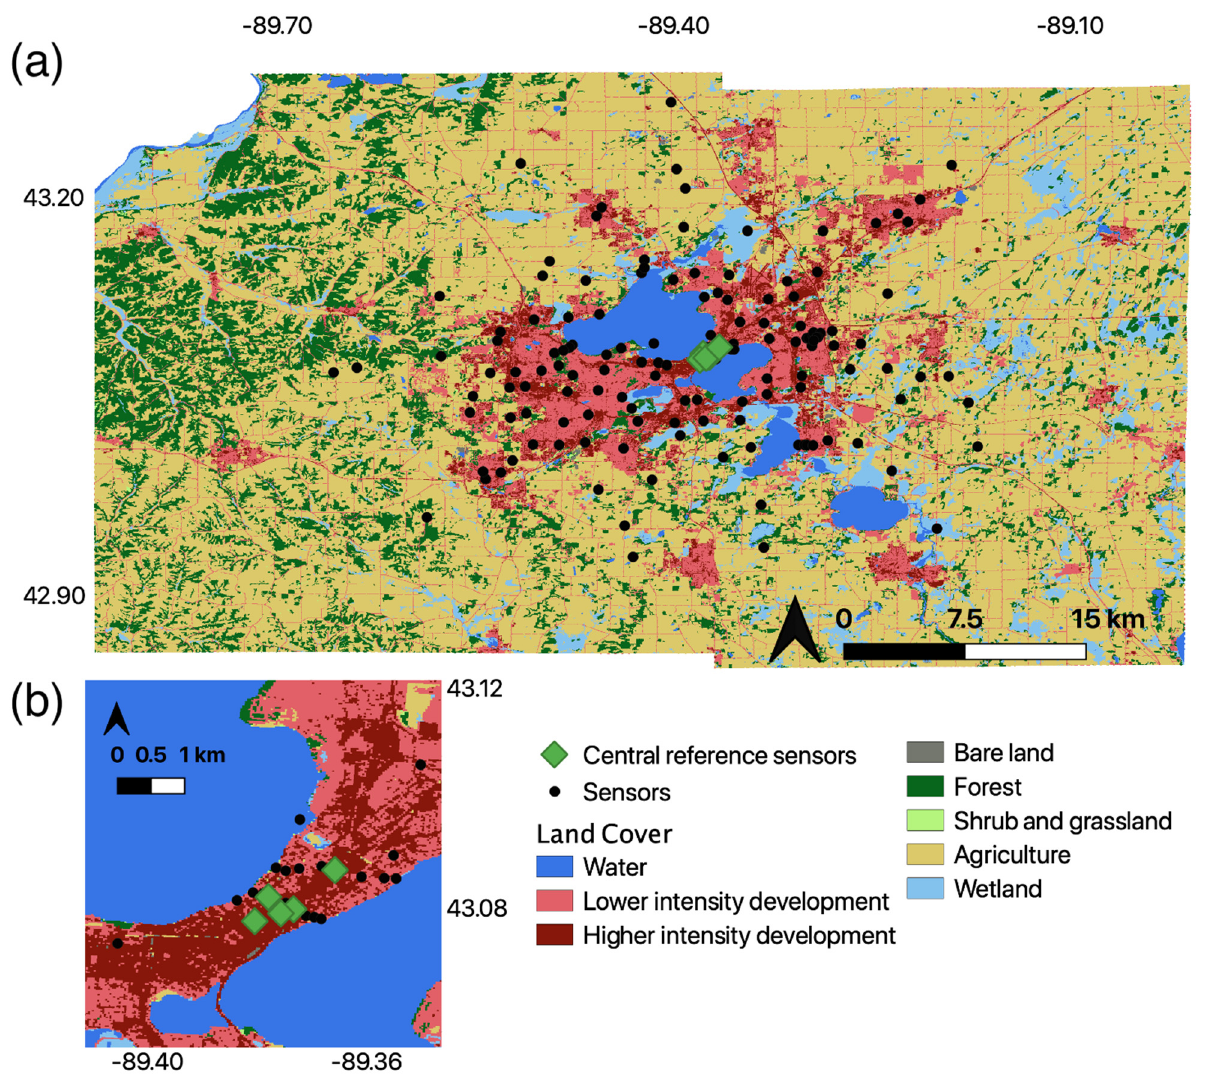
Figure 1. Maps of land cover over ( a ) the entire study area (Dane County, Wisconsin), and ( b ) down- town Madison. Locations of all stationary air temperature/relative humidity sensors are indicated with black dots. Green markers indicate the locations of the five sensors used as central reference points.